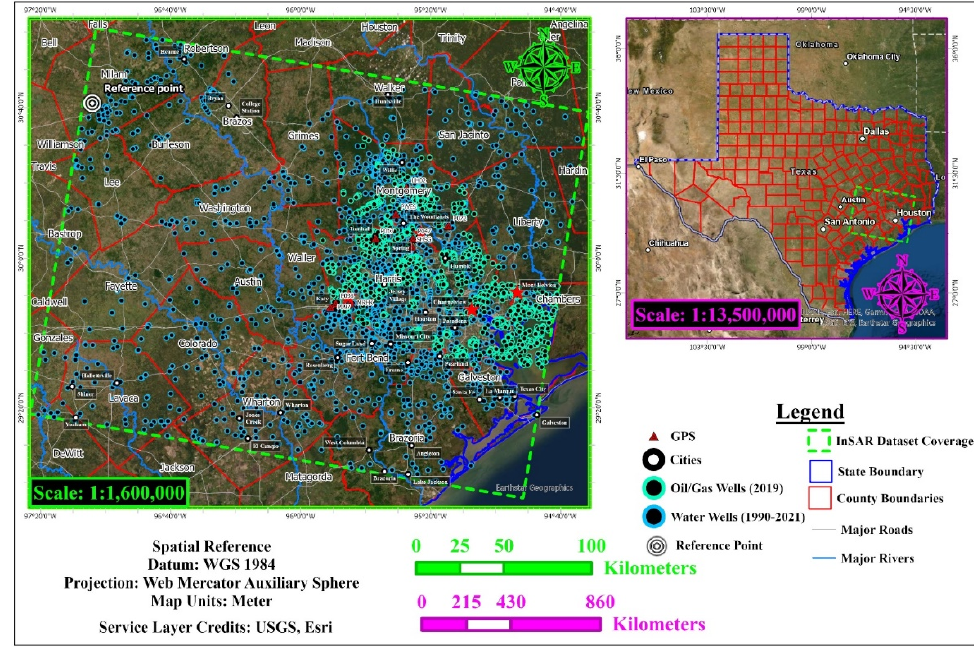
Figure 1. Map of study area showing InSAR coverage area, locations of 71,170 water wells, and 5,948 oil/gas wells that were used for optimized hot spot analysis.